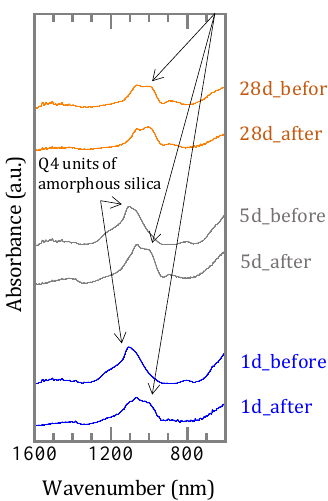
Figure 10. FT-IR spectra of precipitates before and after boron sorption.